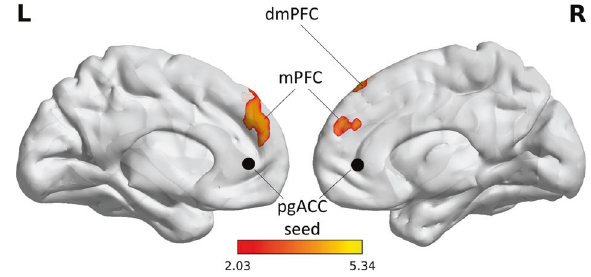
Fig. 3 PgACC resting-state functional connectivity during S-ketamine infusion. PgACC rsFC increases during infusion in the S-ketamine arm. MPFC ( x = 2, y = 56, z = 24, k = 924, Bonferroni adjusted α = 0.025, p FWEc < 0.001) and dmPFC ( x = 40, y = 38, z = 52, = 0.005). dmPFC k = 338, Bonferroni adjusted α = 0.025, p FWEc dorsomedial prefrontal cortex, mPFC medial prefrontal cortex, pgACC pregenual anterior cingulate cortex, rsFC resting-state functional